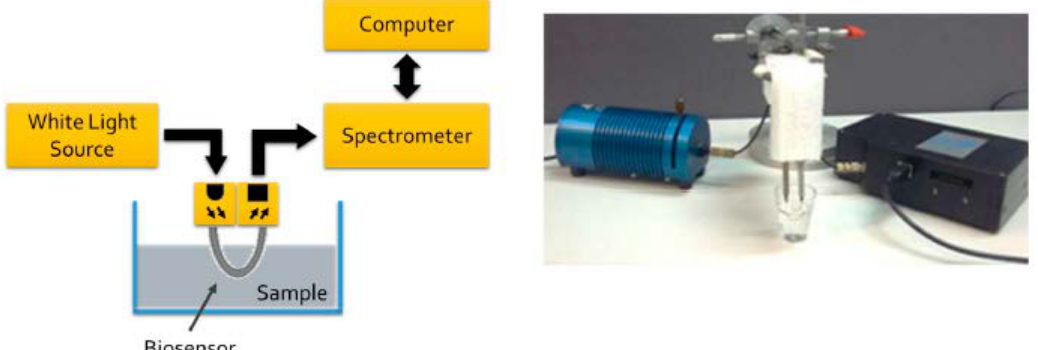
Figure 11. The schematic overview of experimental setup of U-shaped plasmonic fiber-optic biosensor with a white light source (left panel) and the actual setup with light source on the left and spectrometer on the right side of the fiber probe (right panel). Figure reproduced under the terms of the CC-BY Creative Commons attribution 4.0 from Reference [35], Copyright 2018.